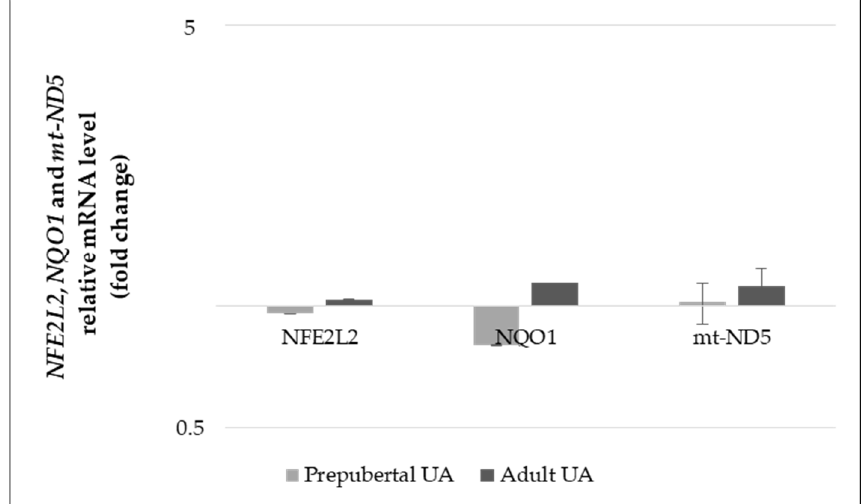
Figure 4. Gene expression levels of NFE2L2 , NQO1 and mt-ND5 in granulosa cells (GCs) from pre- pubertal and adult cows (prepubertal: control, Urolithin A (UA); adult: control, UA, n = 5 for each group) supplemented with UA in the medium culture. Results are normalized to the β -actin gene. mRNA levels in control GCs for NFE2L2, NQO1 and mt-ND5 genes were set to 1. Data are expressed as the CT value mean ± standard error mean (SEM).